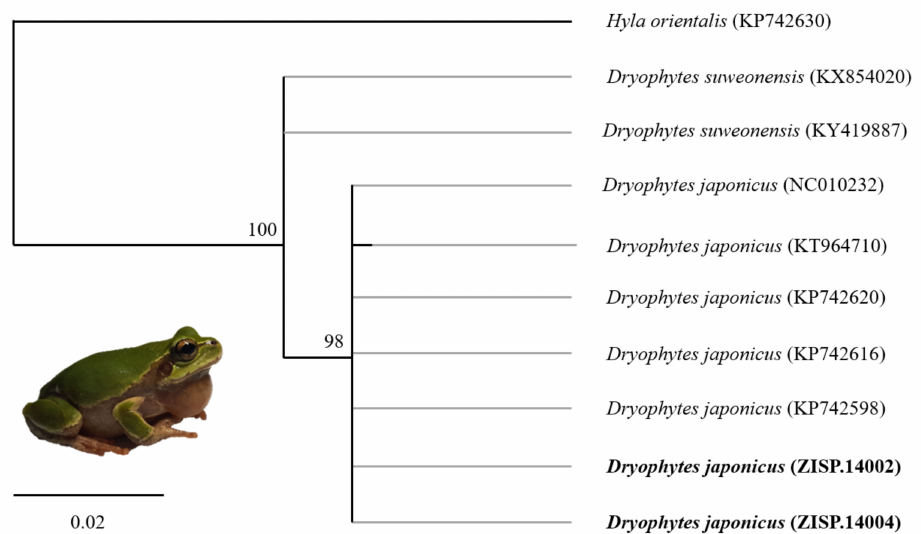
Figure 3. Simplified maximum likelihood phylogenetic tree built with the PHYML plugin in Geneious for Dryophytes sp. samples. The results clarify the presence of D. japonicus in the vicinity of Pyongyang, DPR Korea. Hyla orientalis is used as outgroup in this analysis (GenBank accession numbers shown in Table 2). Branch distances represent nucleotide substitution rates and the scale bar represents the number of changes per nucleotide position. Samples originating from this study are shown in